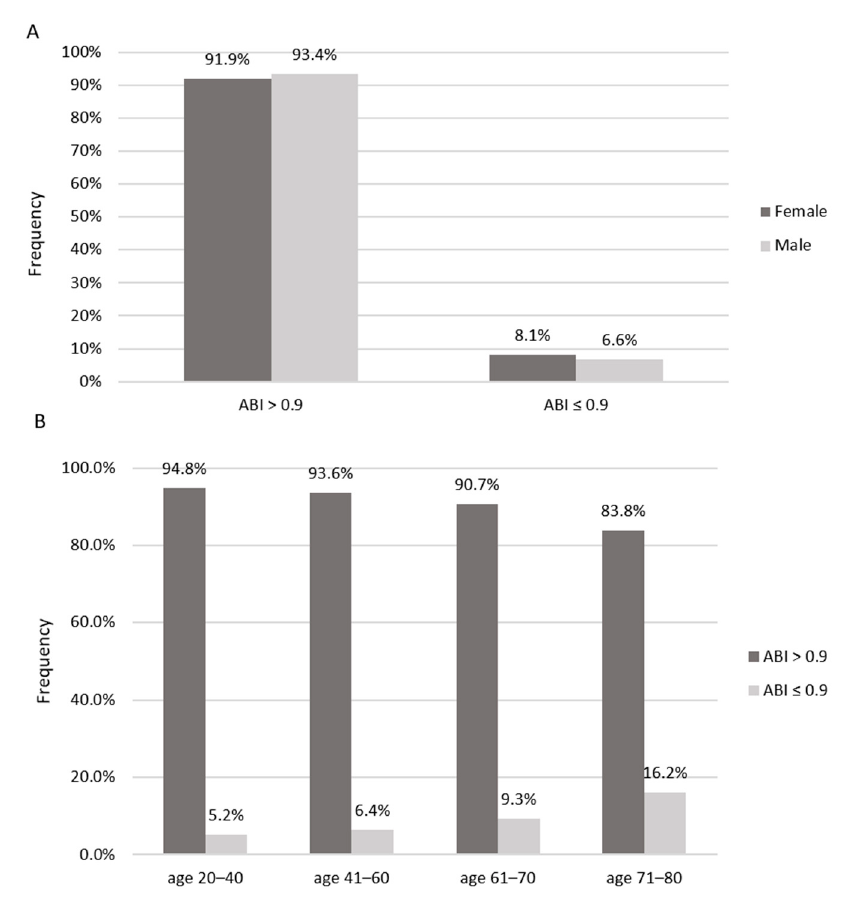
Figure 3. Prevalence of an ABI ≤ 0.9 by gender ( A ) and age groups ( B ). Table 4. Characteristics of the study group depending on the ABI ≤ 0.9.